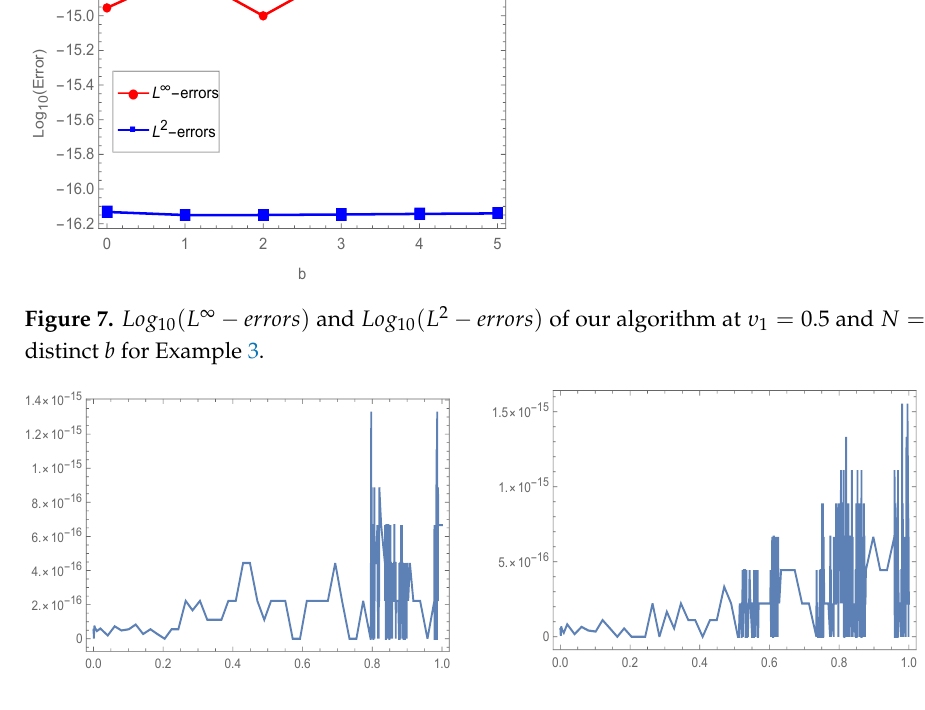
Figure 8. MAE of Z N ( x ) of our algorithm for υ 1 = 0.5 and N = 15 with b = 0 (figure at left ) and b = 2 (figure at right ) for Example